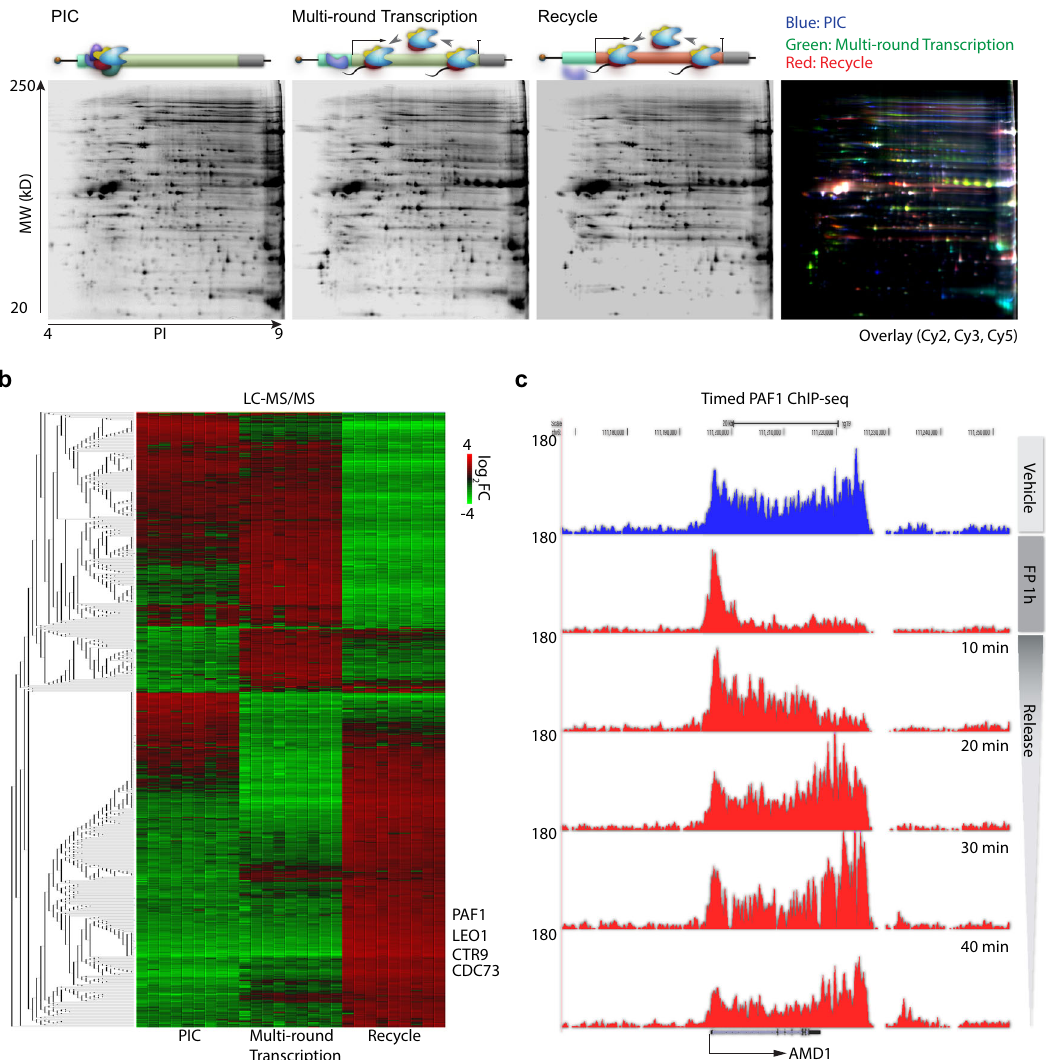
Fig. 2 Pro fi ling of in vitro transcription on the sequential template. a Representative two-dimensional gels showing proteins bound to the sequential template in individual transcription steps. b Heatmap showing pro fi ling of proteins identi fi ed by LC-MS-MS/MS across all individual transcription steps on the sequential template. c UCSC Genome Browser views of a representative PAF1 time course ChIP-seq in LNCaP-abl cells. Source data are provided as a Source data fi